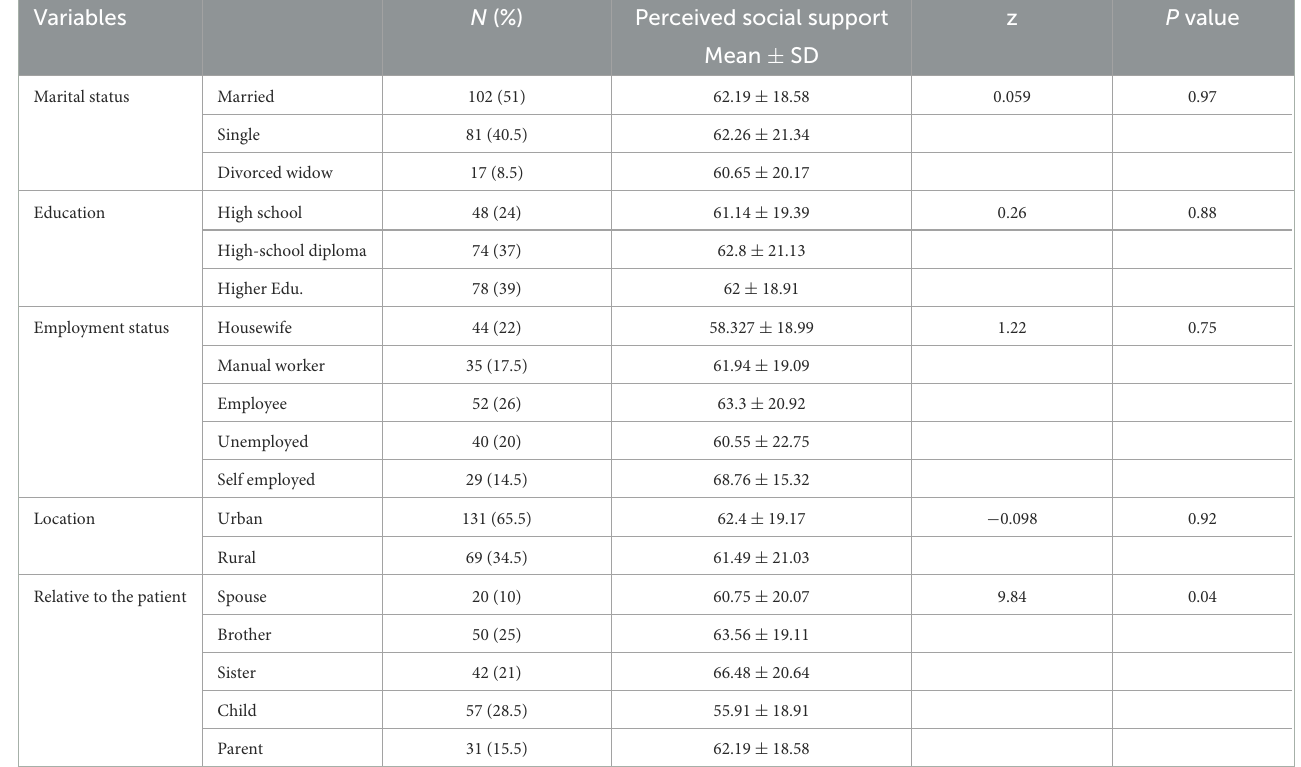
TABLE 2 Demographic variables of research units in quantitative study section and perceived social support condition. Variables